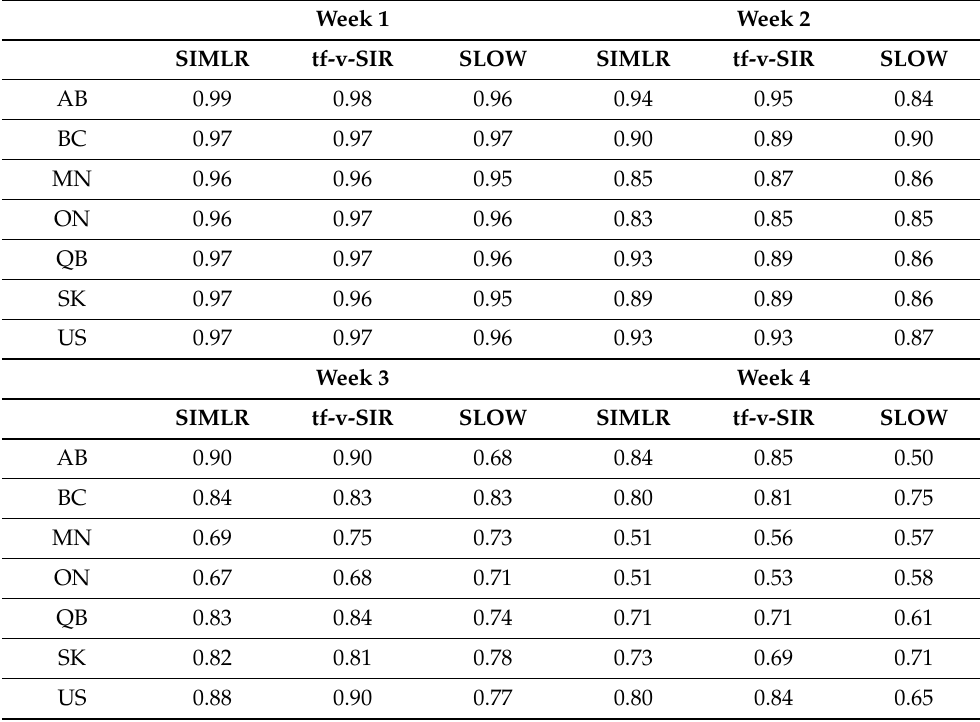
Table 3. Pearson correlation coefficient between the ground truth and the predictions of the six biggest provinces in Canada and United States as a country one- to four-weeks in